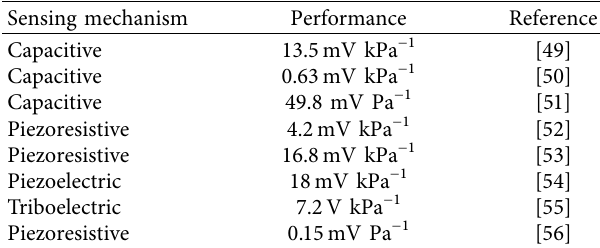
Table 2: Representative sensing system for pulse wave